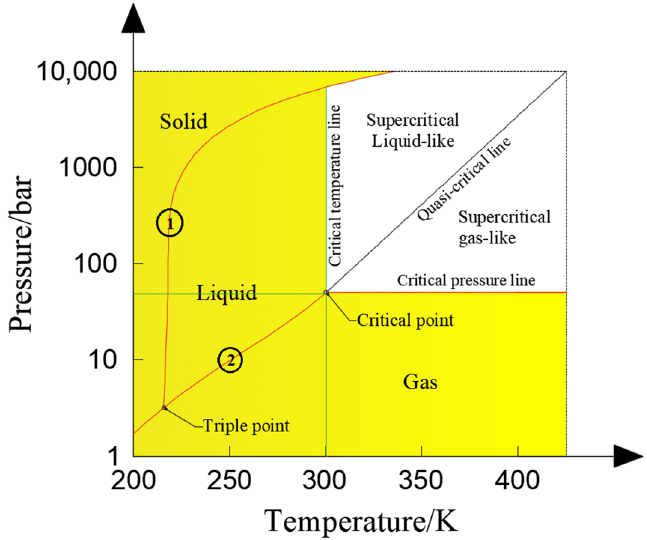
Figure 1. Phase diagram of CO 2 .